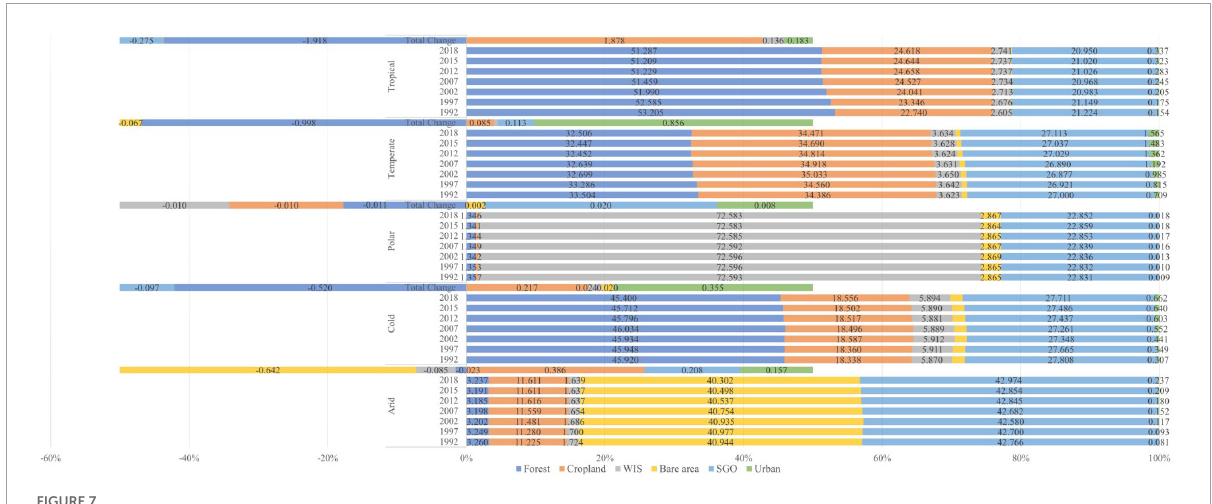
FIGURE7 The percentage land-cover changes for each year by climatic